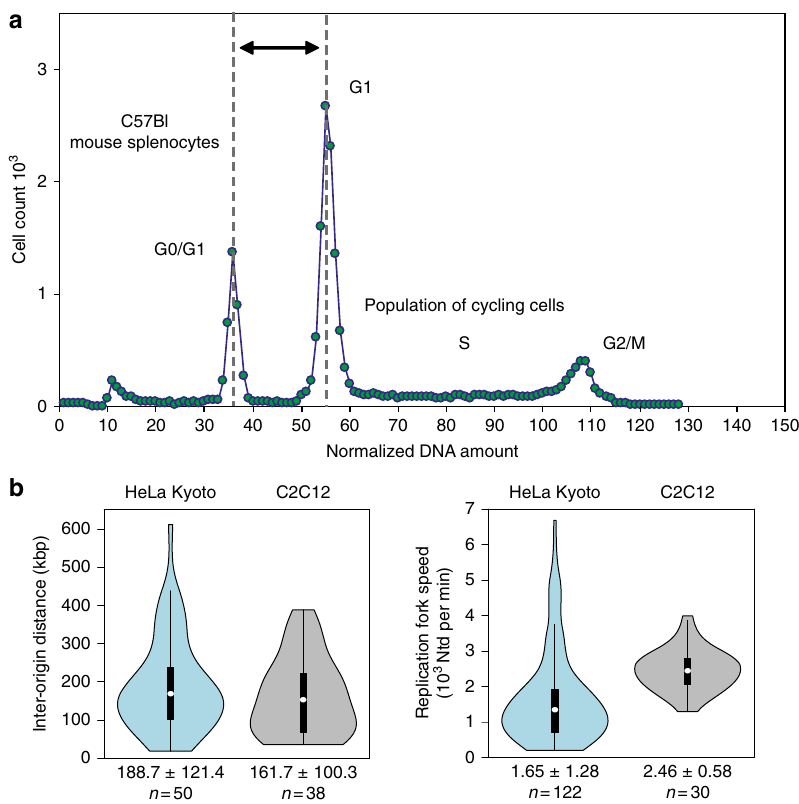
Figure 2 | Genomic DNA content and DNA fibre analysis of replicons. ( a ) DNA flow cytometry histogram of ethidium bromide/olivomycin stained HeLa Kyoto mCherry-PCNA expressing cells admixed with C57Bl mouse splenocytes is shown. The peak at channels 34–38 corresponds to the G1/G0 peak of non-cycling splenocytes. HeLa Kyoto cell cycle distribution is represented by a typical DNA flow cytometry histogram consisting of G1, S-phase and G2/M populations. To calculate the amount of genomic DNA in the cycling cell line, G1/G0 peak of mouse splenocytes and G1 peak of the cell line were approximated with Gaussian distributions and the relative position of the G1 peak was calculated (for details see methods and Table 2). ( b ) Cells were pulse labelled with IdU for 30min, followed by a 30min CldU pulse. Whole-genome DNA was extracted under gentle conditions and single DNA fibres were stretched with the constant factor of 2kbpper m m. Incorporated nucleotides were immunostained and signals acquired in a wide-field microscope. Fluorescent tracks were measured by hand and used to calculate mean IOD and RFS. For details see methods; Supplementary Fig. 2 and Tables 3 and 4.